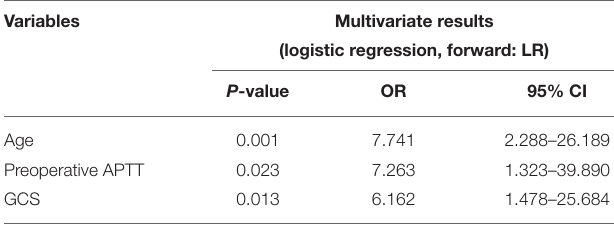
TABLE 2 | Multivariate logistic regression analysis for 30-day mortality after primary DC.